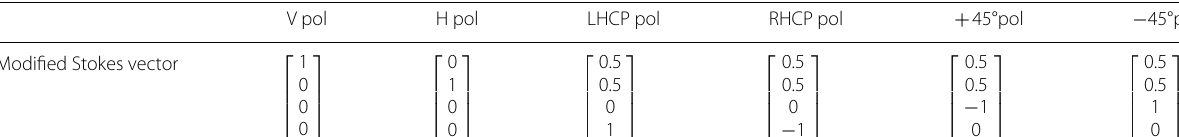
Table 2 Modified Stokes vectors for various polarizations V pol H pol Modified Stokes vector